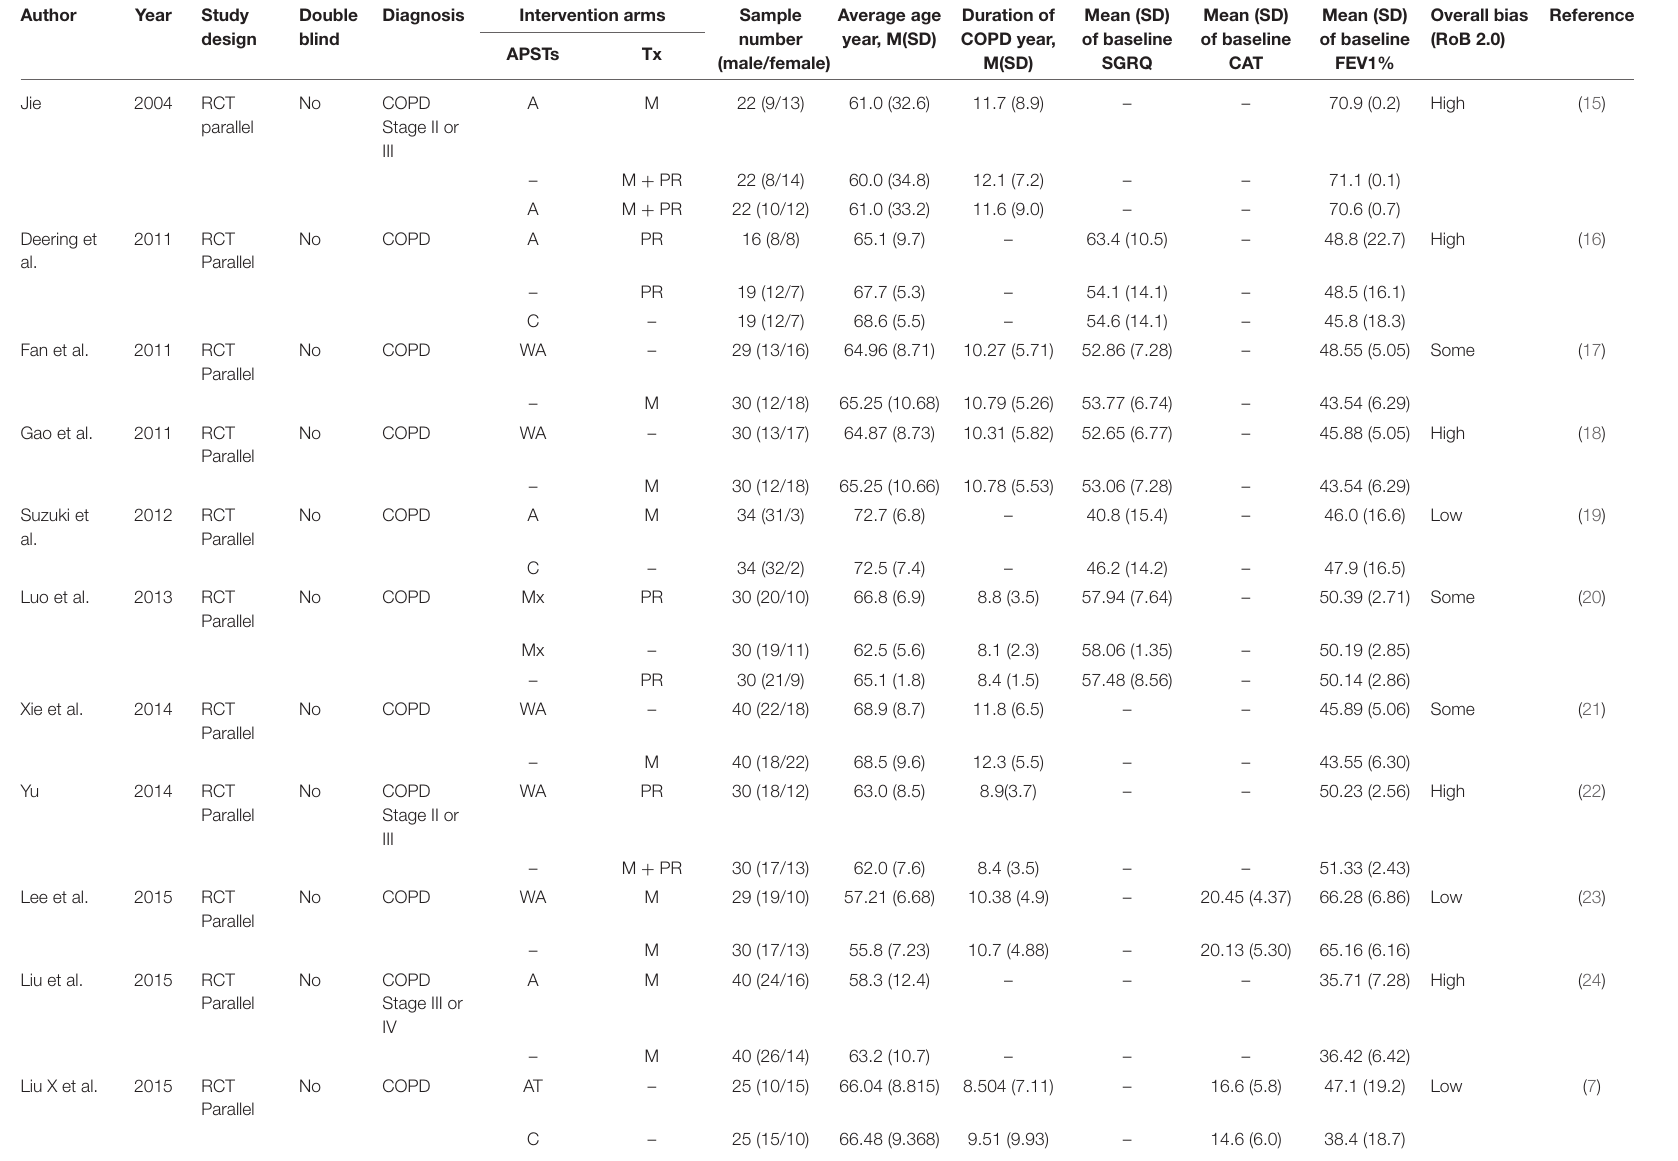
TABLE 2 | Summary of the retrieved